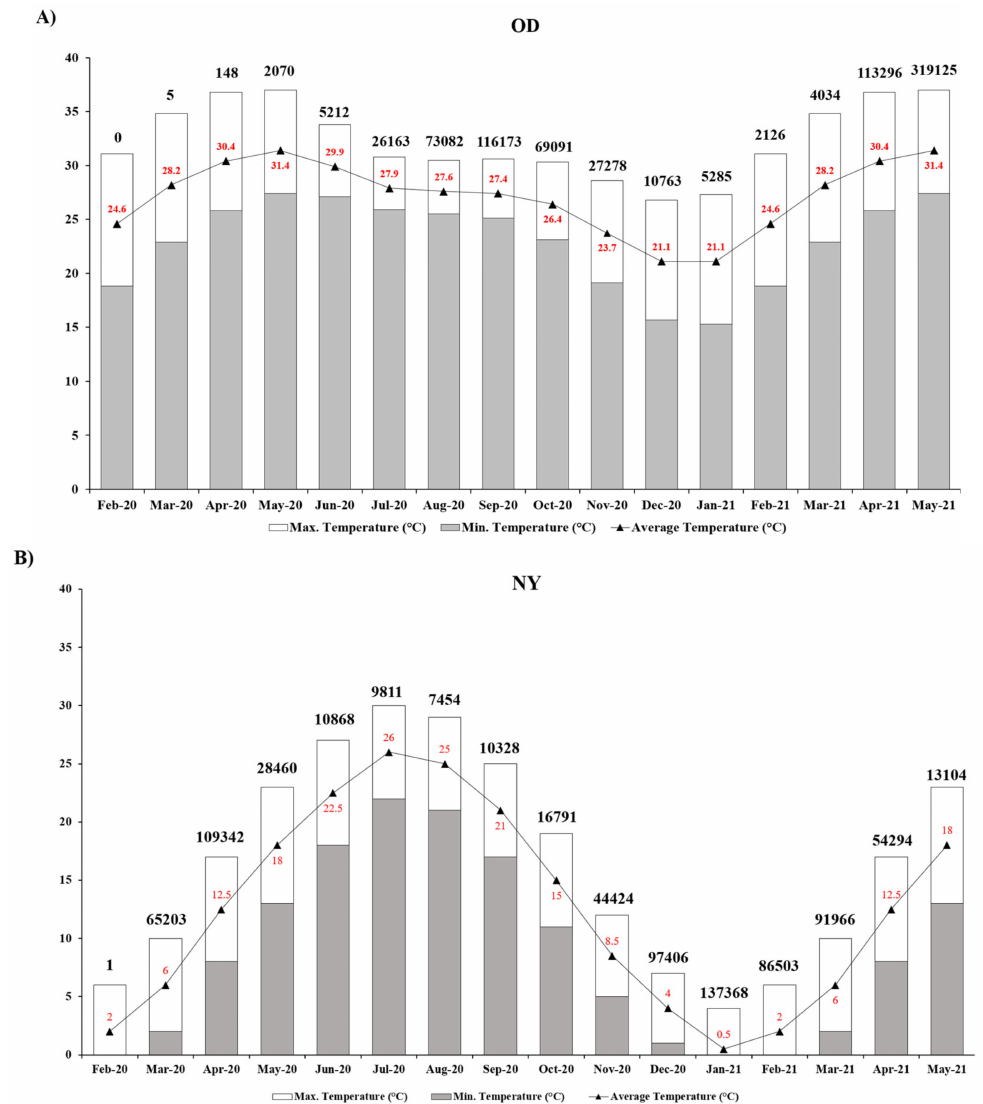
Figure 2. Graphical representation of monthly average surface temperature in ( A ) OD and ( B ) NY from February 2020 to May 2021. Confirmed case numbers for individual months are shown above each bar graph. Abbreviations: OD, State of Odisha, India. NY, State of New York,